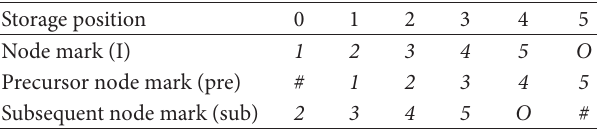
Table 6: Storage of P chain